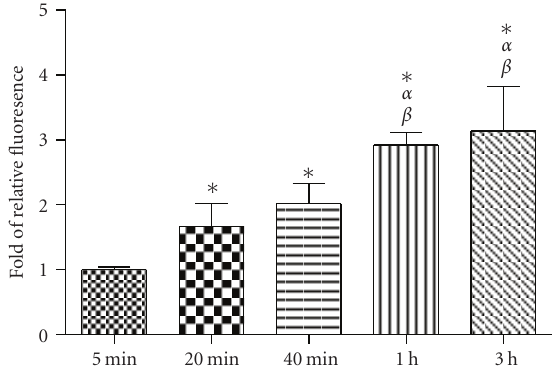
Figure 3: Time-dependent uptake of QD/SR9. QDs were premixed with SR9 at a molecular ratio of 1 :20. A549 cells were treated with QD/SR9 at 150 nM QD concentration for 5 min, 20min, 40min, 1 hour, and 3 hours. Values are mean ± SD from three independent experiments. Fluorescence intensity is normalized relative to the value at 5min. ∗ P < . 01 versus 5min; α P < . 01 versus 20min; β P < . 01 versus 40 min.